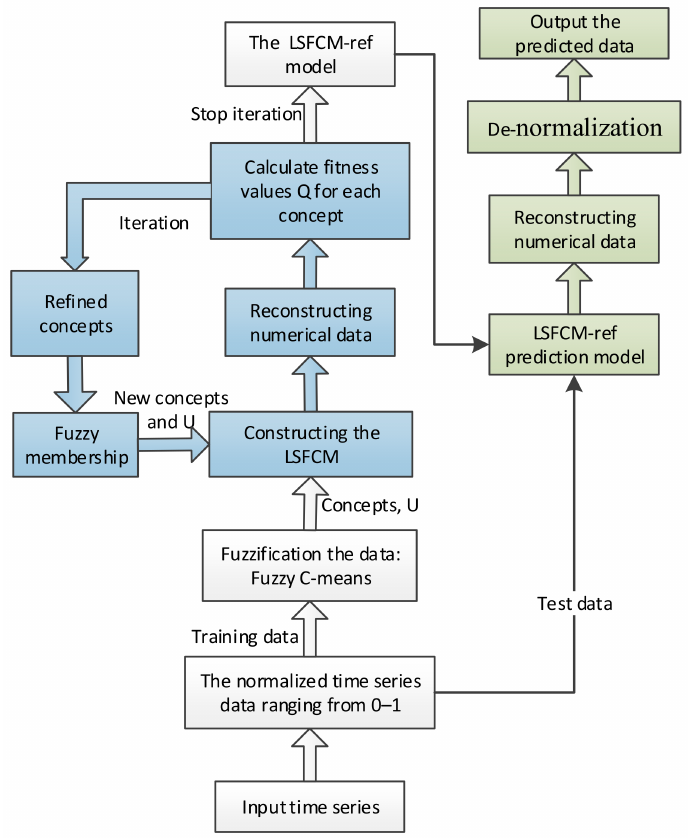
Figure 2. The outline of proposed method for the time series